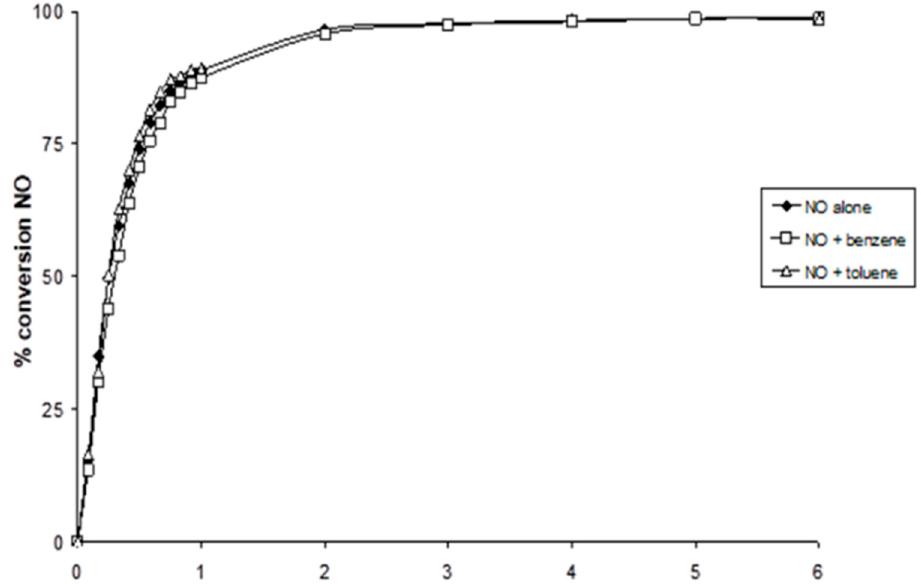
Figure 4. Photocatalytic degradation of NO alone and in the presence of benzene and toluene (RH: 20%). A similar result was obtained at RH 60%.